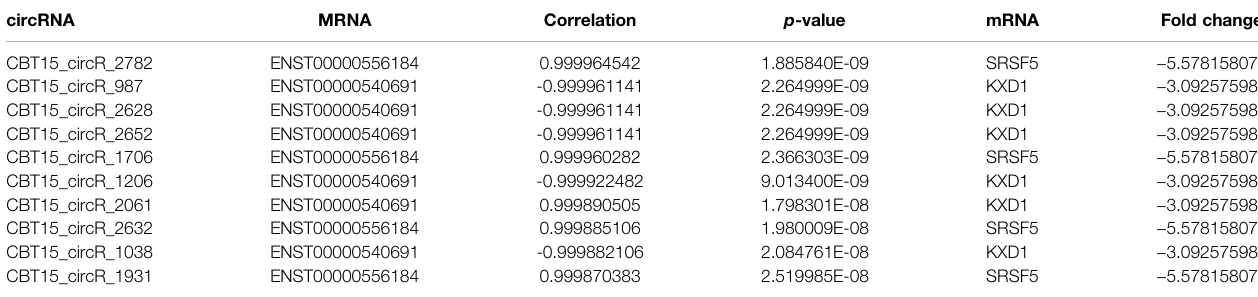
TABLE 4 | The top 10 coexpressed circRNAs and mRNAs in moDCs.